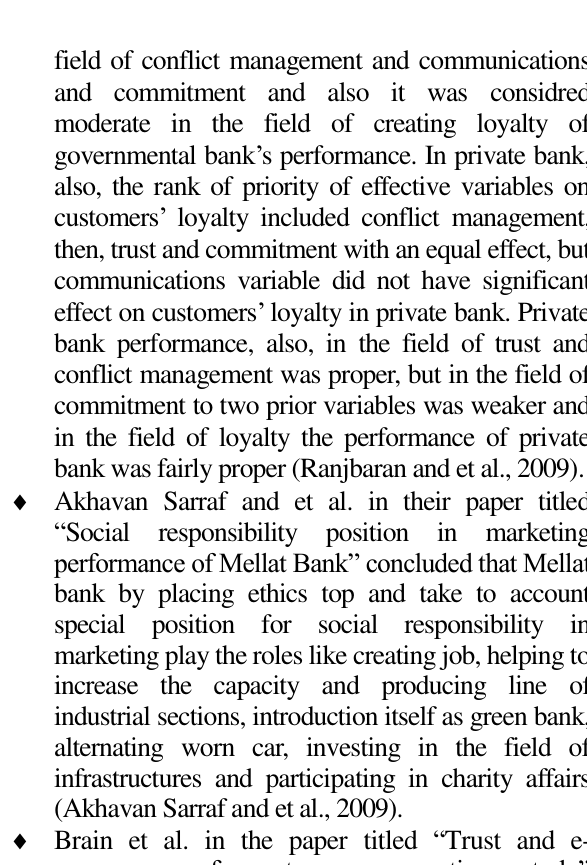
Fig. 4. Link model between loyalty and market